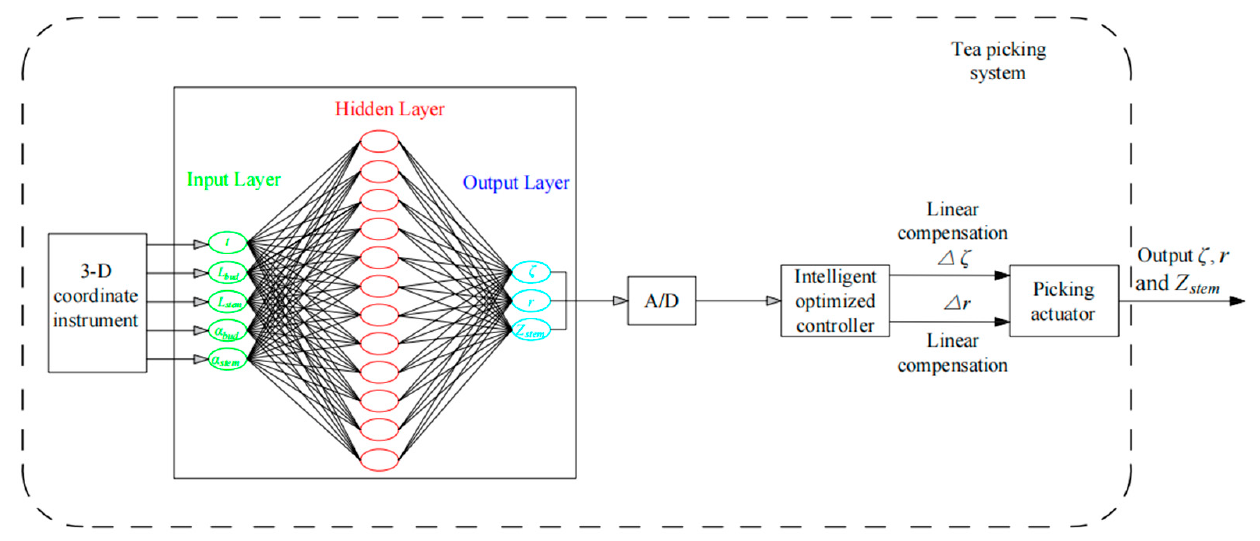
Figure 13. The application scheme of the established 5-2-12-3 ANN model.